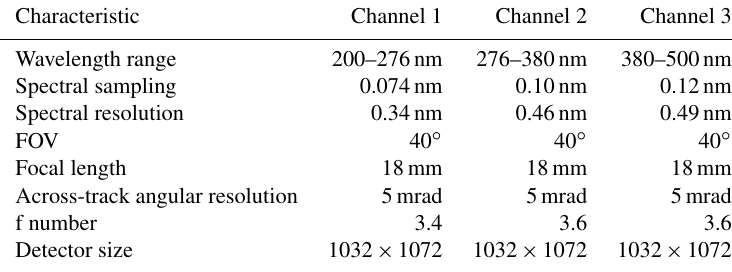
Table 1. UVHIS instrument characteristics of three